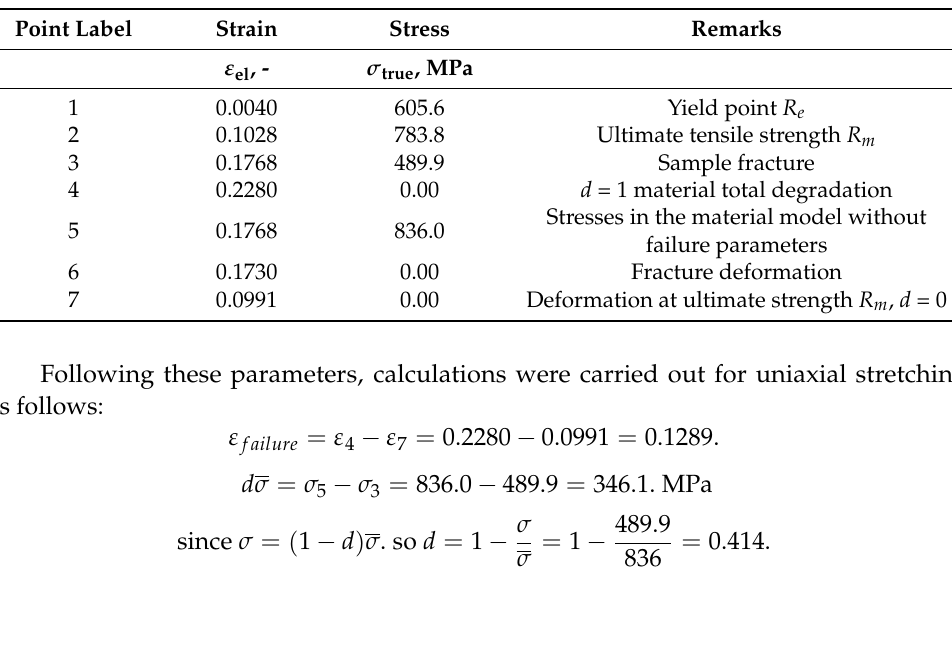
Figure 9. Failure diagram on the true characteristics of HY 80 steel ( σ true - ε true ). Table 5. The values in Figure 9 used in the